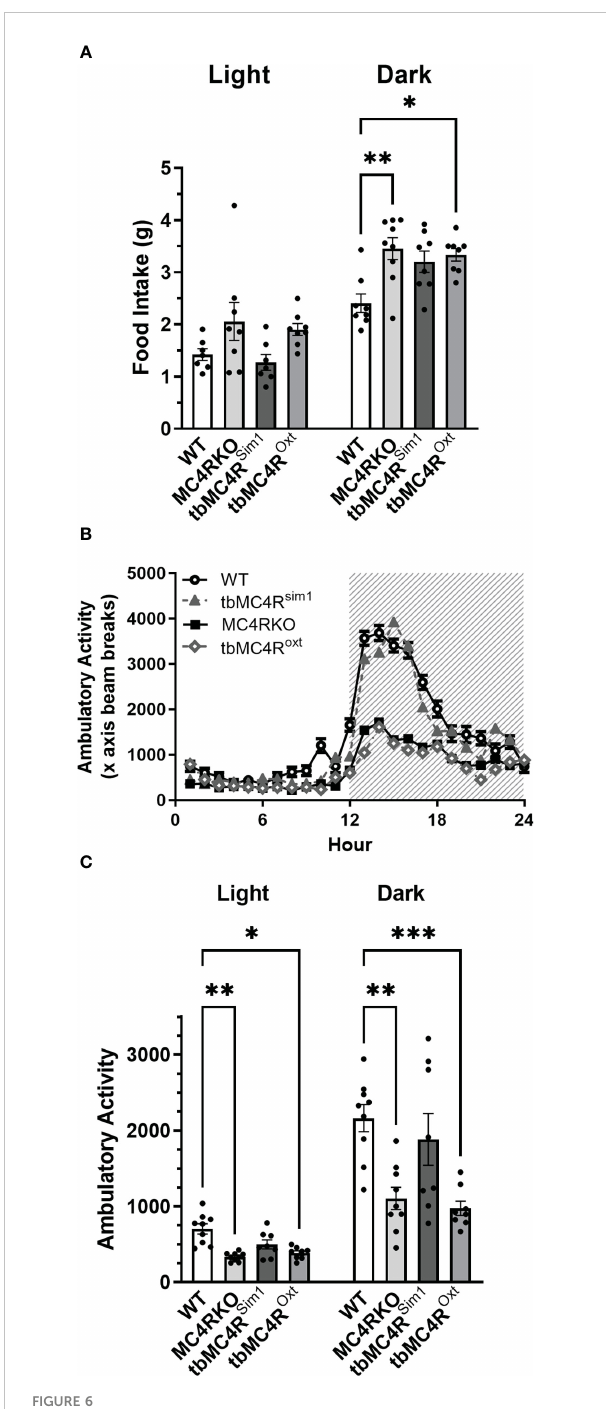
FIGURE 6 Expression of the MC4R on Sim1 neurons normalizes food intake and locomotion. Food intake in day and night (A) , ambulatory activity along the x-axis (B) , and area under the curve for diurnal and nocturnal ambulatory activity (C) as measured in calorimetric cages for WT (n=7-9), MC4RKO (n=8-9), tbMC4R Sim1 (n=7-8), and tbMC4R Oxt mice (n=8). One-way ANOVA with Sidak ’ s multiple comparisons test was used for graph A. Brown-Forsythe and Welch ANOVA tests with Dunnett ’ s T3 multiple comparisons test was used for graph C. Graph A night, WT vs MC4RKO (p=0.003) and tbMC4R Oxt (p=0.018). Graph C day, WT vs MC4RKO (p=0.005) and tbMC4R Oxt (p=0.012). Graph C night, WT vs MC4RKO (p=0.004) and tbMC4R Oxt (p=0.0008) *p<0.05; **p<0.01;